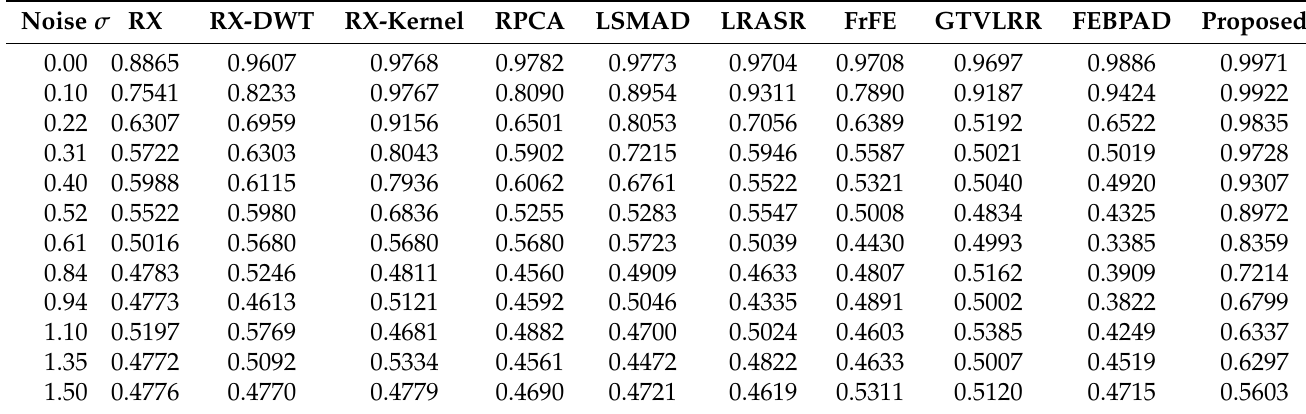
Figure 16. Detection results for the AVIRIS-I dataset with Gaussian noise ( σ = 0.1): ( a ) Pseudo-color image; ( b ) RX; ( c ) RX-DWT; ( d ) RX-Kernel; ( e ) RPCA; ( f ) LSMAD; ( g ) LRASR; ( h ) FrFE; ( i ) GTVLRR; ( j ) FEBPAD; ( k ) proposed method; ( l ) ground truth. Table 3. AUC values of the proposed method and methods used for comparison on the AVIRIS-I dataset under different degrees of Gaussian